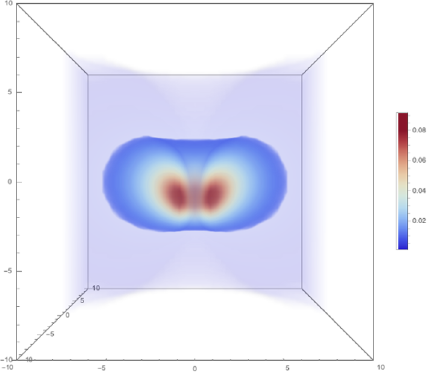
Figure 5 . Cut of the amplitude of the magnetic (cid:13)ux at y = 0 for tan (cid:12) =